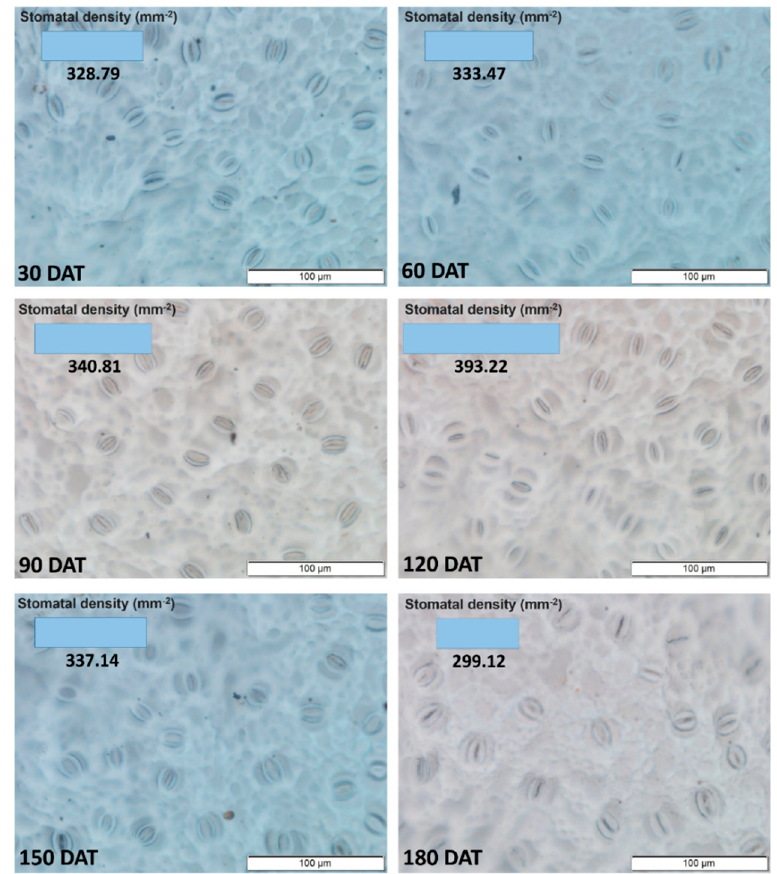
Figure 1. Density of stomata in the axial epidermis of the leaves of the seedlings of Hymenaea courbaril L., raised in a hydroponic system and sampled at different intervals of their initial development (30, 60, 90, 120, 150, and 180 days after transplantation).